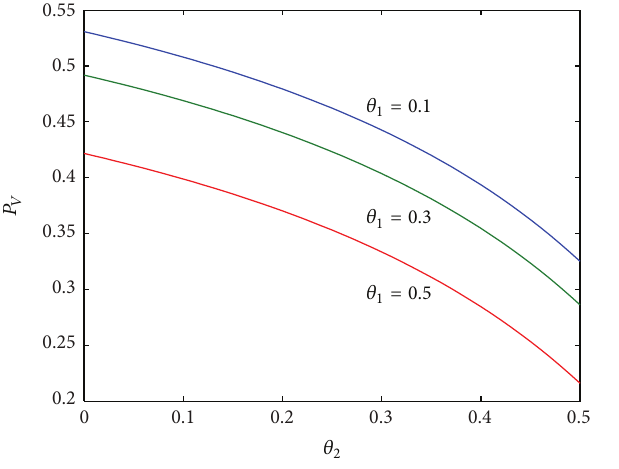
Figure 4: The curve of 𝐸(𝑁) with 𝜃 2